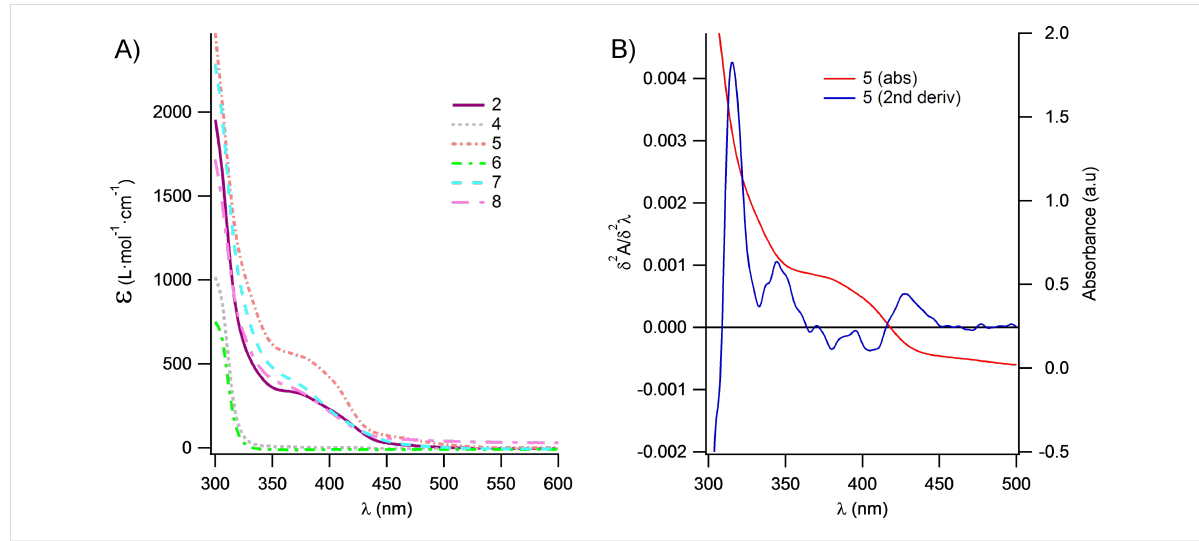
Figure 1: (A) UV–vis absorbance spectra were taken in DMSO. (B) The second derivative of the compound 5 calculated from A. Other metal complexes have similar second derivative bands but are omitted for